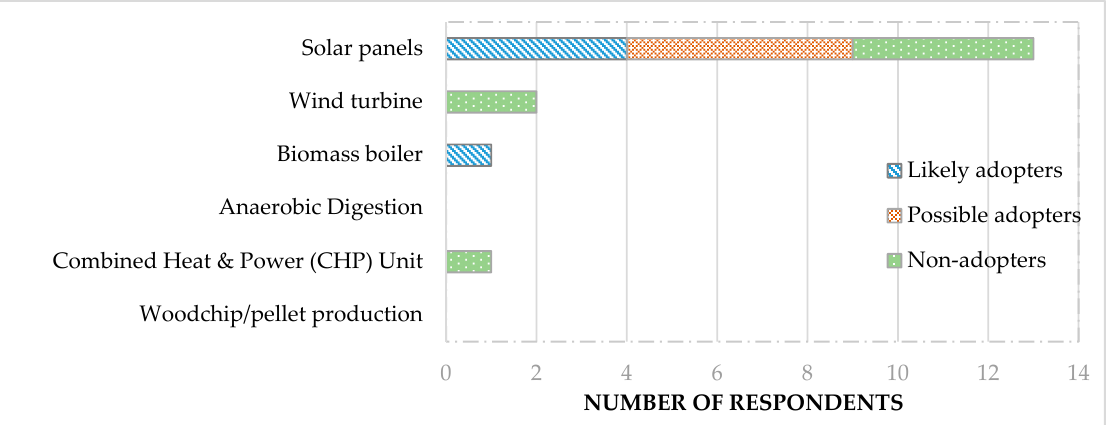
Figure 2. Farmer’s previous implementation of renewable technologies.